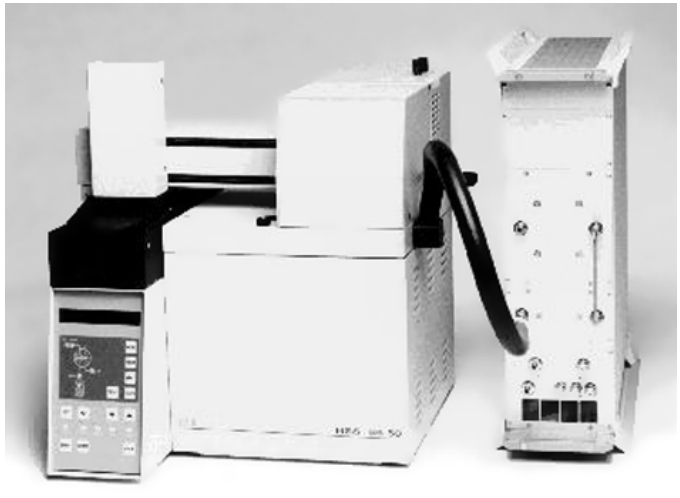
Figure 1 . E-nose system used as a stationary device (photograph by courtesy of Udo